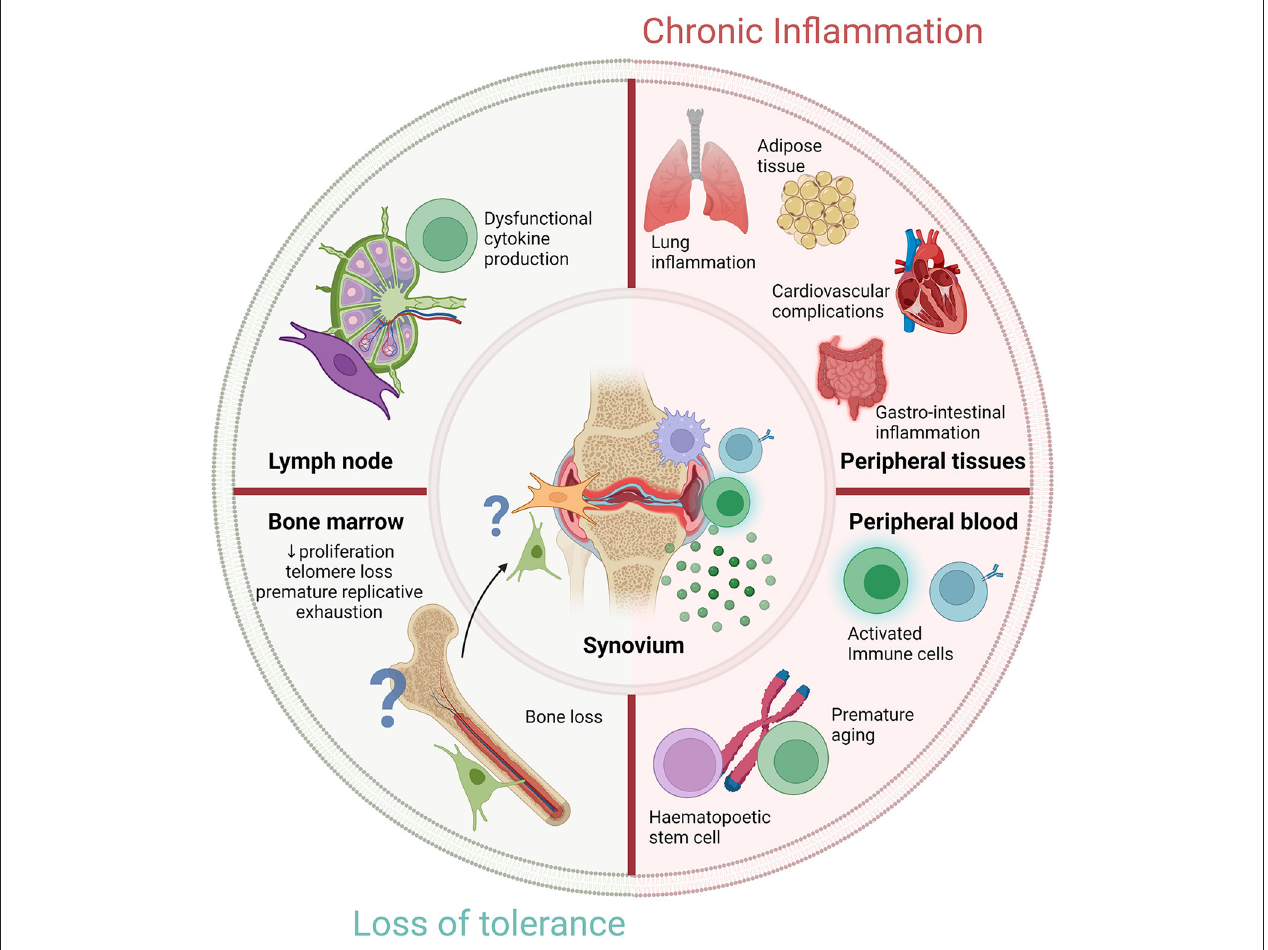
FIGURE 2 | Novel targets to restore cellular fitness before RA development. Diagram representing novel targets of either chronic inflammation or loss of tolerance to prevent RA development in RA-risk individuals. Outer circle shows four critical areas that show significant changes in early RA. Lymph node and bone marrow alterations are observed, potentially due to a loss of tolerance in RA which warrant further investigation. Timely normalization of cellular fitness within lymphoid organs or other peripheral tissues could possibly prevent RA development in RA-risk individuals. Peripheral blood research may identify predictive biomarkers for early diagnosis or disease prognosis. Chronic inflammation is observed in distinct locations outside the synovium but whether these are the consequence of a loss of tolerance or caused by inflammation is unknown. The locations of the outer circle culminate in the chronic inflammatory environment observed within the synovium but how exactly they contribute warrants further examination. Created with